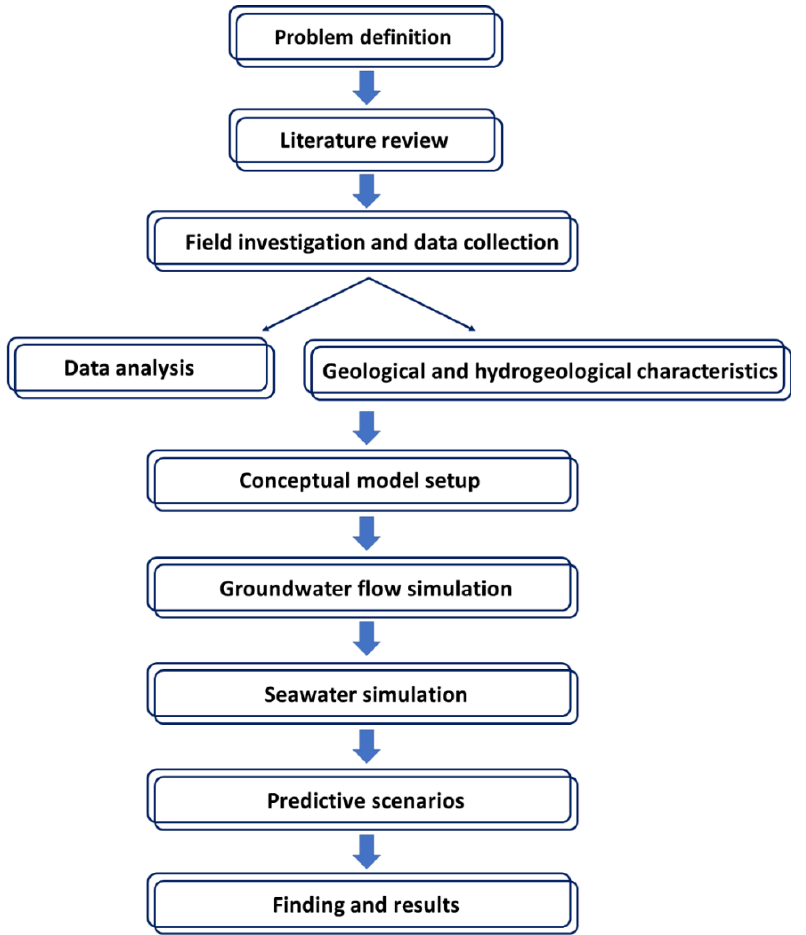
Figure 5. Flow chart explaining the development of the groundwater modelling study .